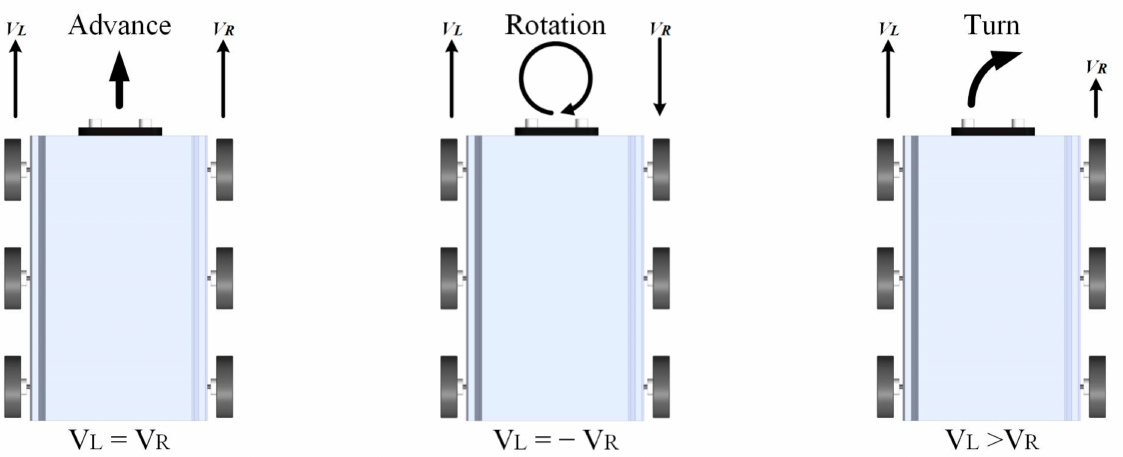
Figure 9. The principle of differential